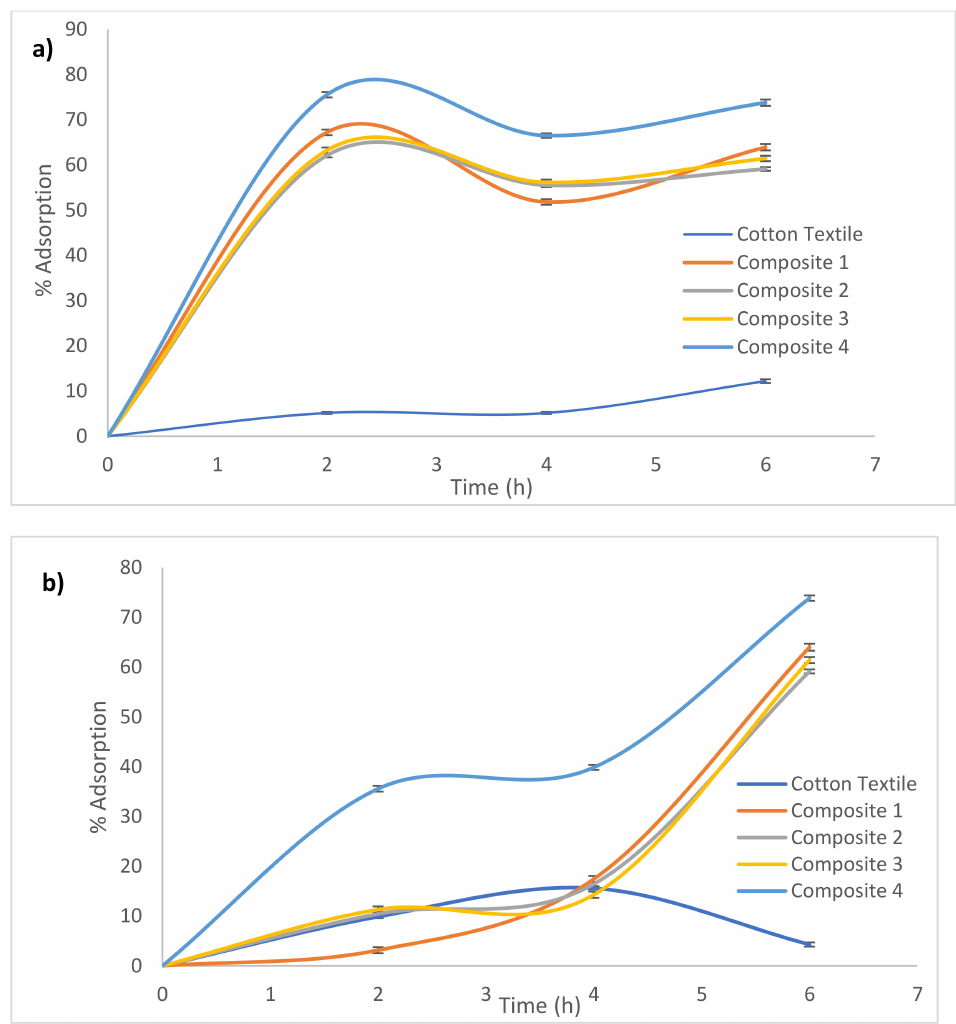
Figure 5. Lead adsorption percentage of composites and cotton textiles in ( a ) PbO solution or ( b ) Pb(NO 3 ) 2 solution, both at pH